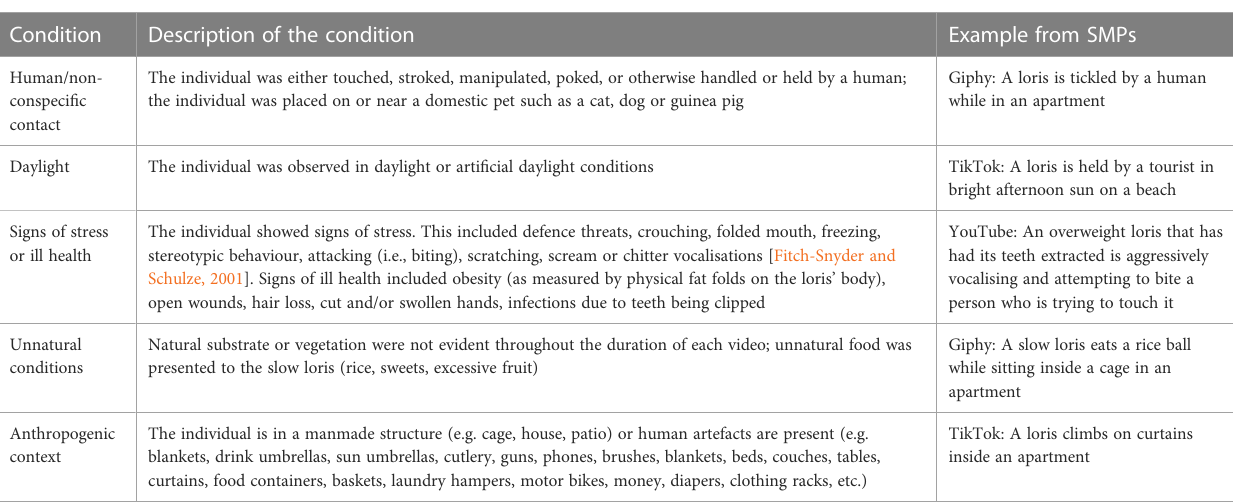
TABLE 1 Description of each of the fi ve conditions for decontextualization that we coded in 100 slow loris videos across three social media platforms. Condition